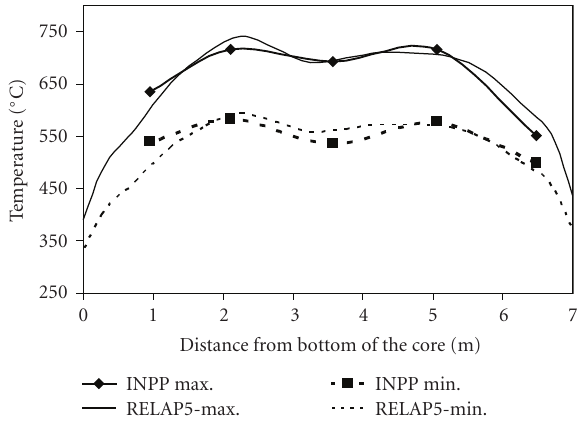
Figure 5: The calculated values of the graphite blocks outer surface temperature for the maximum and minimum power fuel channels (reactor power 4000